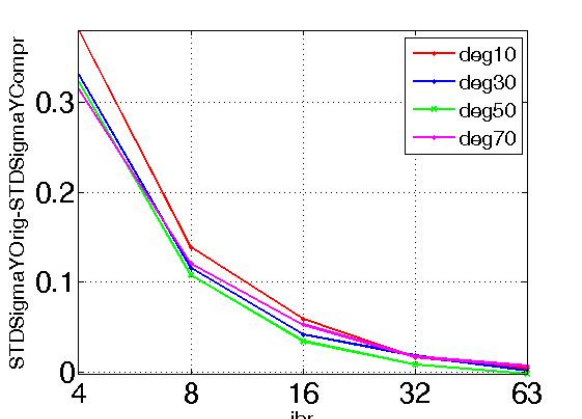
Figure 16: Standard deviations of the differences (pix) between the disparity error map of the original images and the disparity error map of the compressed images for different illumination angles and image